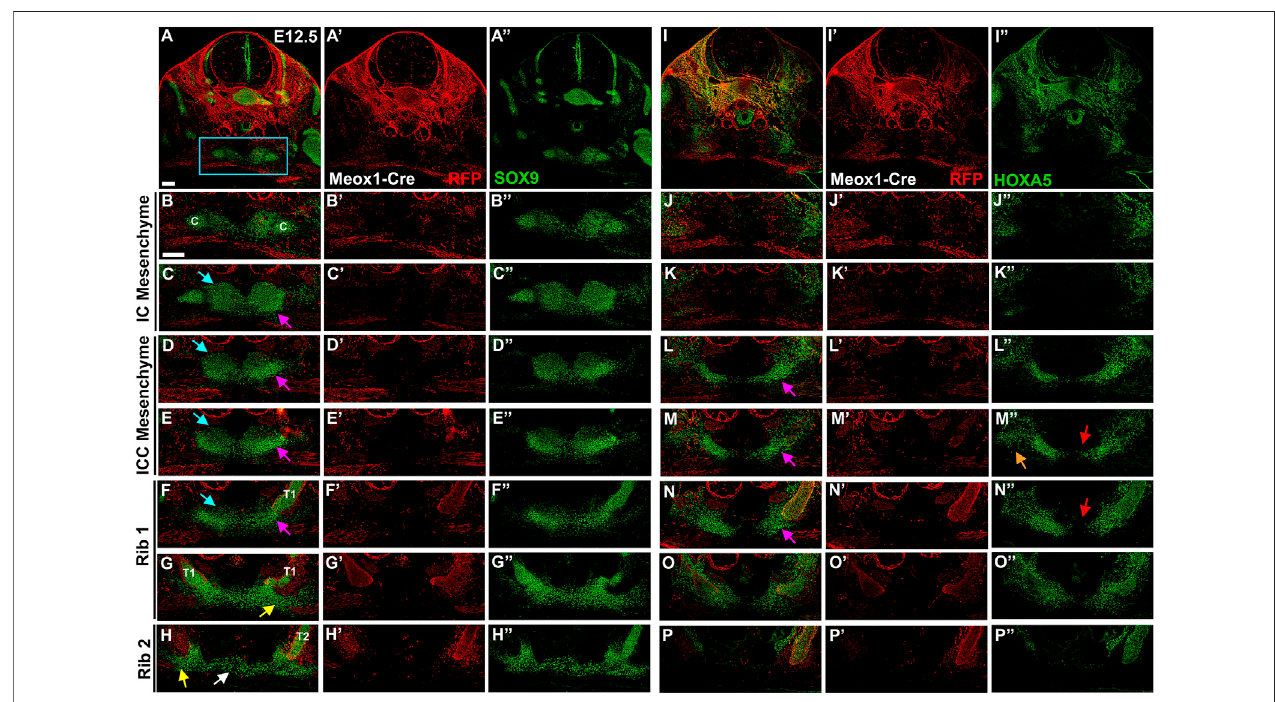
FIGURE 7 | At E12.5, HOXA5 occupies a lateral domain as well as marking the site of rib 1 attachment to the sternum. E12.5 Meox1-Cre-RFP embryo in which alternate sections were labelled for SOX9 (A – H ′′ ) or HOXA5 (I – P ′′ ) . Whole cross-sections are shown in (A) and (I) , with remaining images from the region indicated by blue rectangle in (A) . Images are shown with RFP and either SOX9 (A – H) or HOXA5 (I – P) ; RFP alone ( A ′ – H ′ ; I ′ – P ′ ), or SOX9 (A ″ – H ″ ) or HOXA5 (I ″ – P ″ ) alone. Pink arrows in (C – F) and (L – N) indicateventral ICC. Bluearrows in (C – F) point todorsal IC/ICC. Orange arrow in (M ″ ) indicates lateral HOXA5 expression domain. Red arrows in (M ″ ,N ″ ) point to exclusion of HOXA5 from the medial-most region of the ventral ICC mesenchyme. Yellow arrow in (G,H) marks triangle of SOX9 expression contacting the rib. White arrow in (H) marks stream of cells crossing the midline. Scale bar: 100 μ M. C, clavicle; T1, thoracic rib 1; T2, thoracic rib